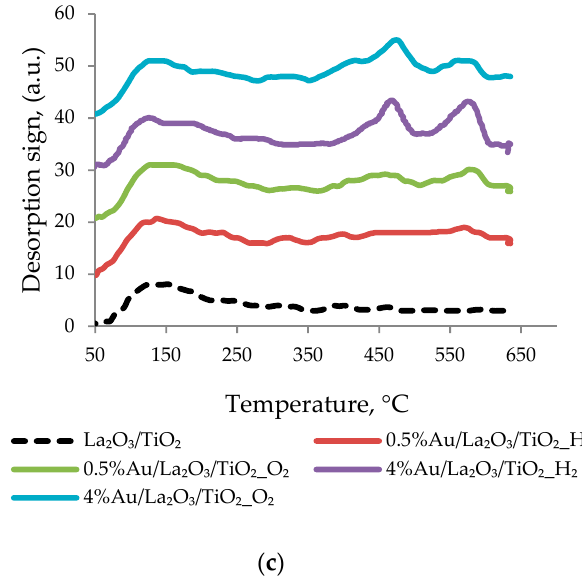
Figure 2. O 2 -TPD profiles for Au nanoparticles on TiO 2 ( a )CeO 2 /TiO 2 ( b )and La 2 O 3 /TiO 2 ( c )with different pretreatments.